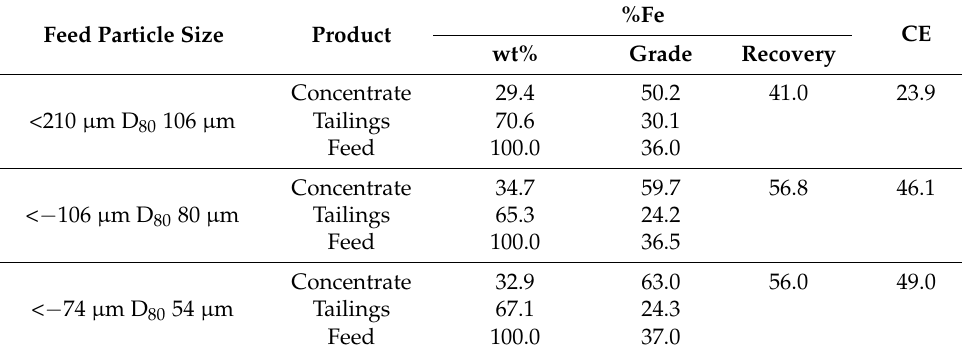
Table 2. Amenability to flotation with varying MOGs.